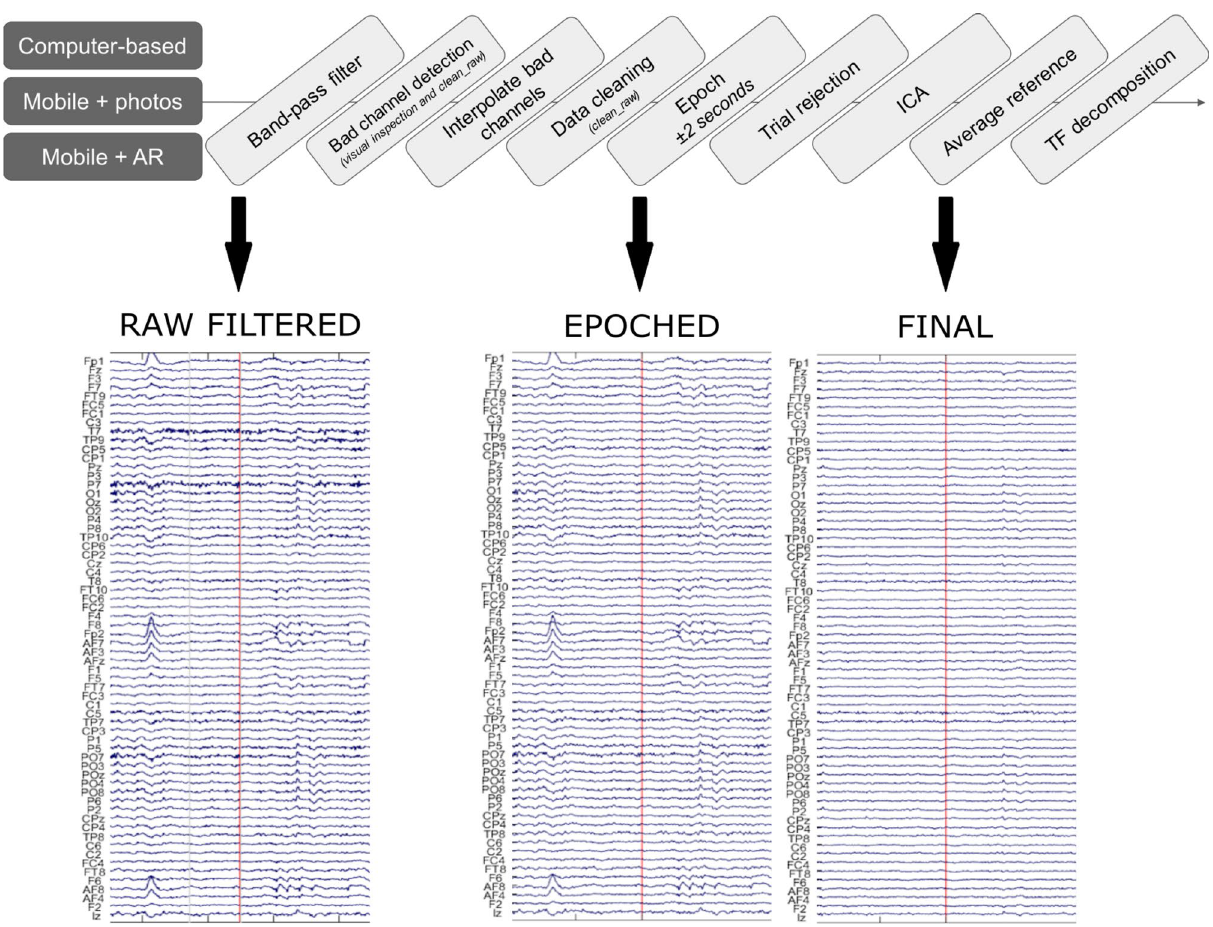
Figure 2. EEG preprocessing. Core methods across task, and example data at different stages of processing from the Mobile + AR